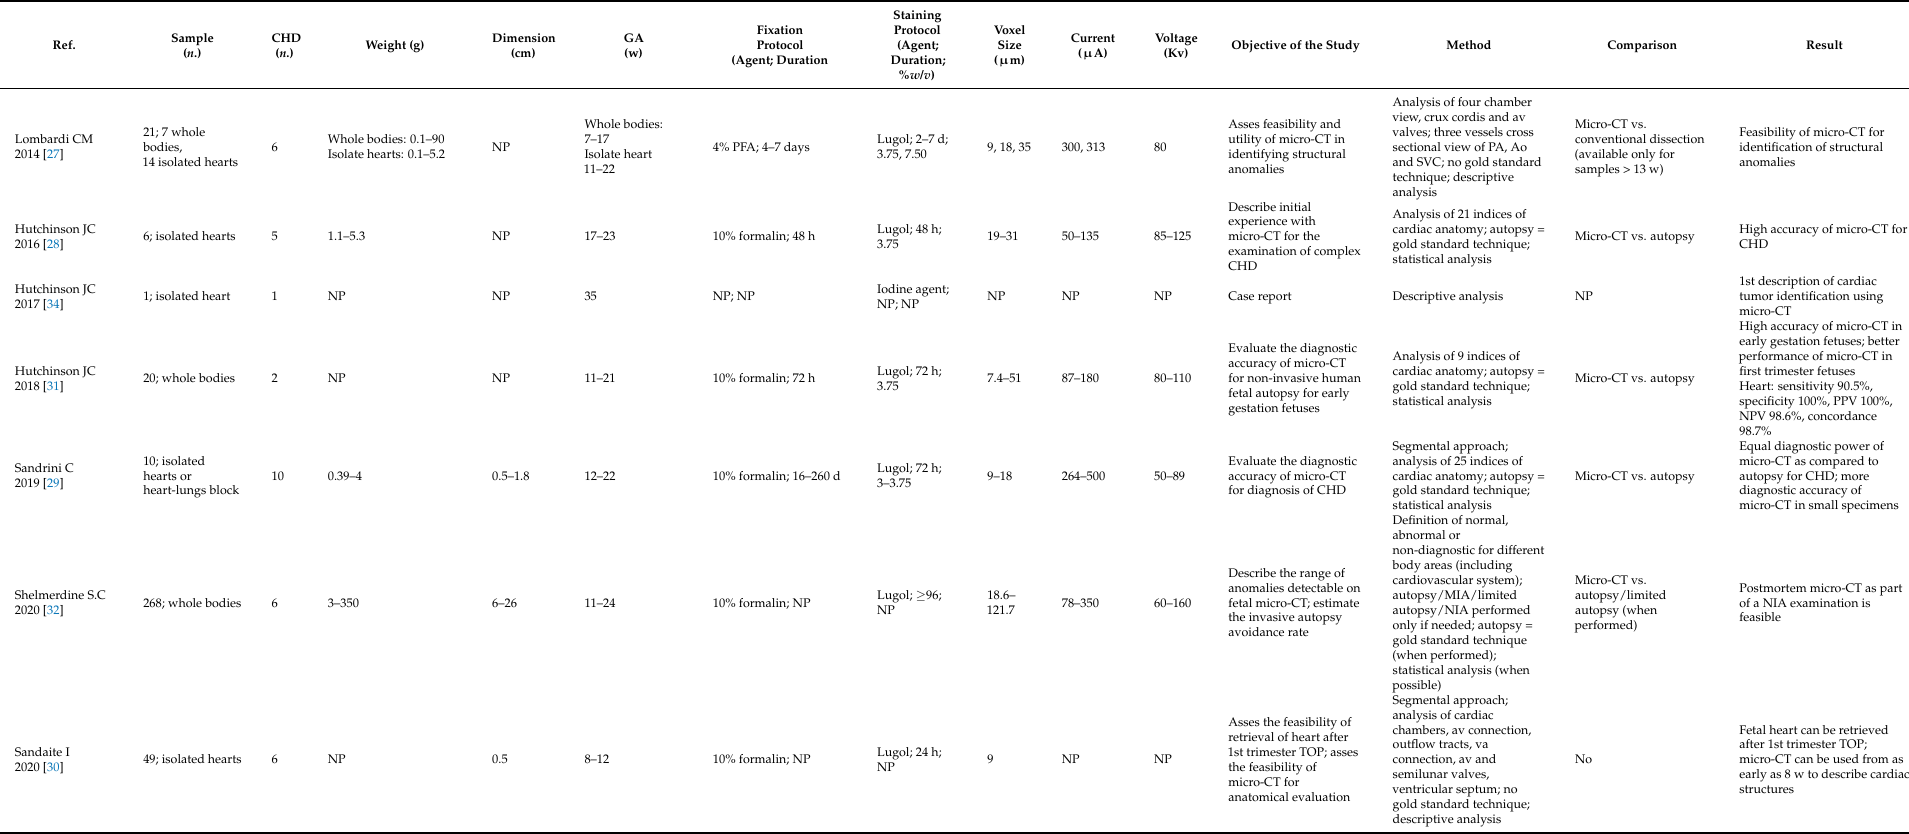
Table 1. Micro-CT in clinical